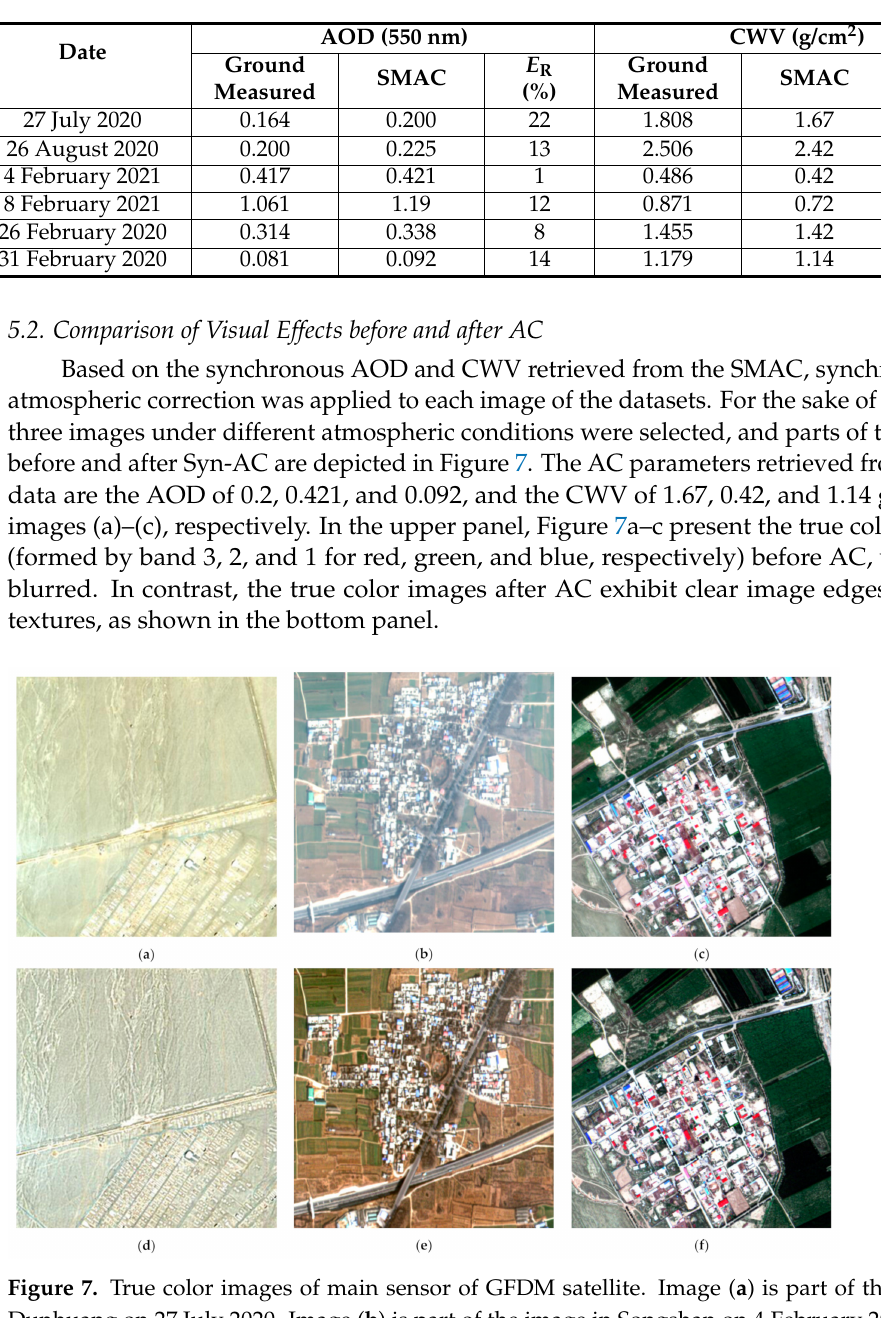
Table 7. Comparison between AOD (550 nm) and CWV (g/cm 2 ) retrieved from SMAC and the ground-based observation.